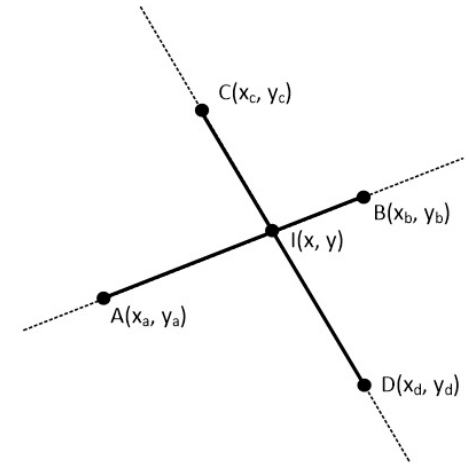
Figure 36. Two lines on a two-dimensional